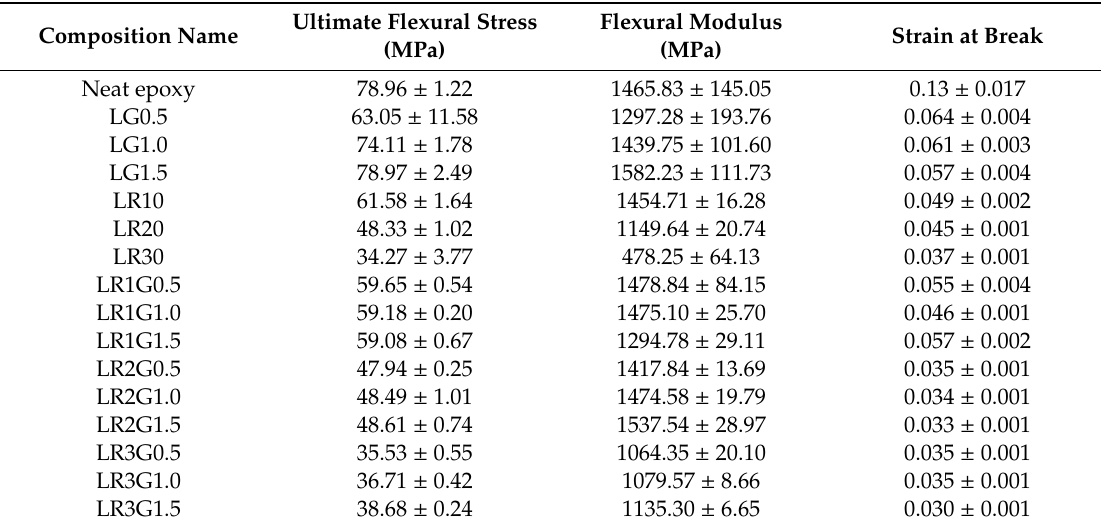
Table 4. Three-point bending (3PB) test